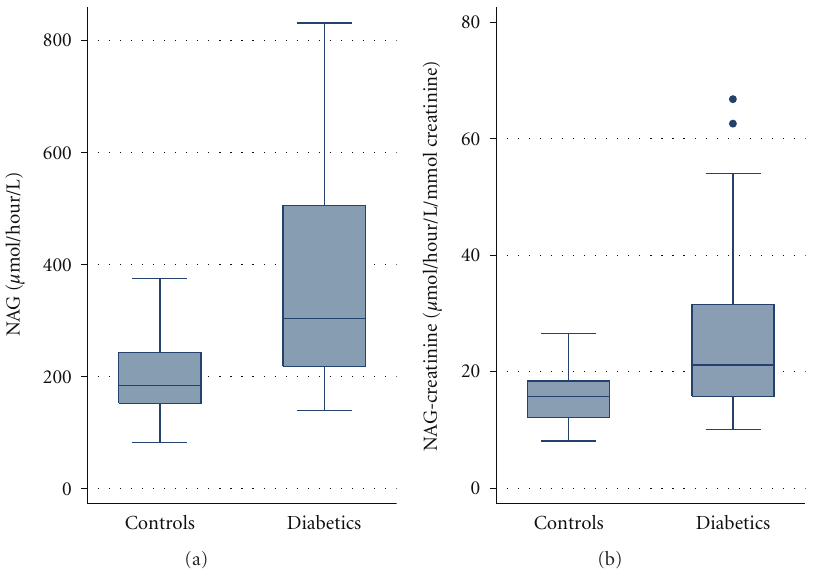
Figure 1: Comparison of NAG/NAG-creatinine ratios in both study groups.